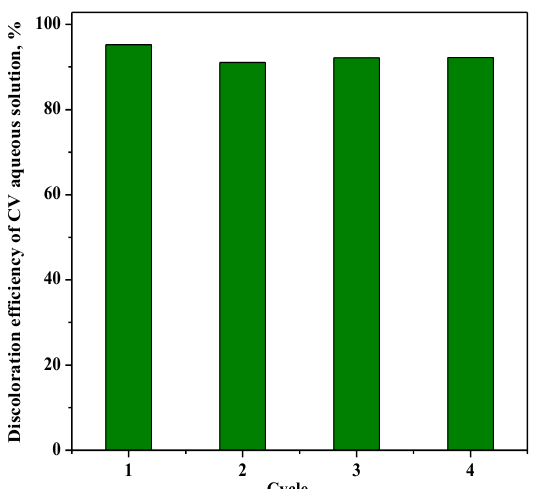
Figure 14. Photocatalytic discoloration of CV with the RM_2.5Fe photocatalyst under visible (white) light irradiation after 180 min: stability of the photocatalyst along four cycles.